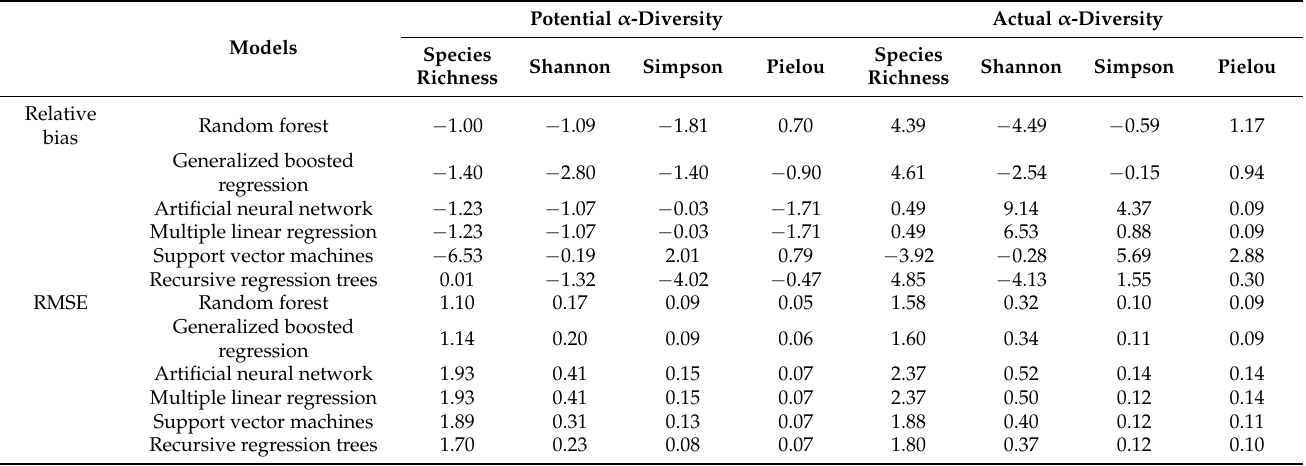
Table 2. The relative bias (%) and RMSE values between observed and simulated potential and actual α -diversity of the plant community ( n =